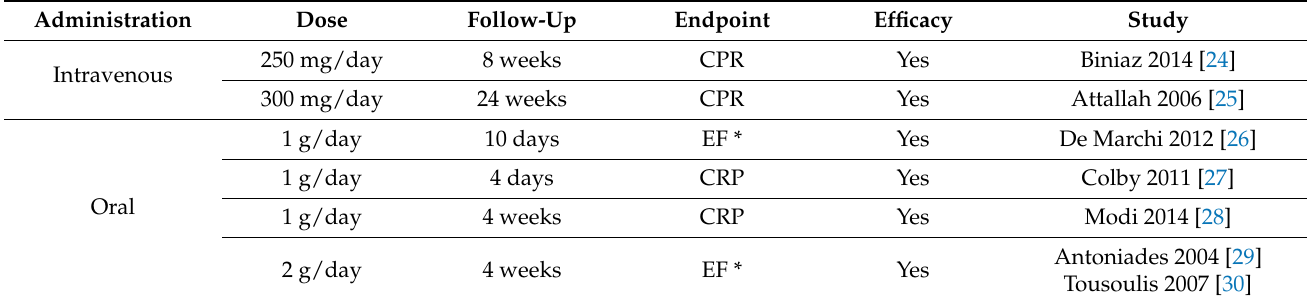
Table 4. Vitamin C: summary of the principal characteristics of the included systematic reviews.